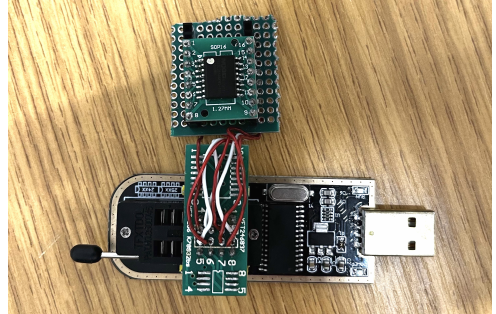
Figure 3: Dumping BMC firmware with a flash